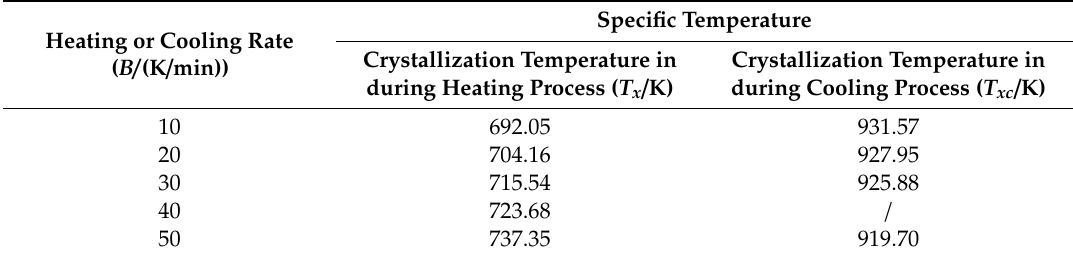
Figure 5. The di ff erential scanning caliometry (DSC) curves with di ff erent ( a ) heating rate and ( b ) Figure 5. The differential scanning caliometry (DSC) curves with different ( a ) heating rate and ( b ) cooling rate. cooling rate. Table 1. The crystallization temperature during the heating and cooling Table 1. The crystallization temperature during the heating and cooling process.